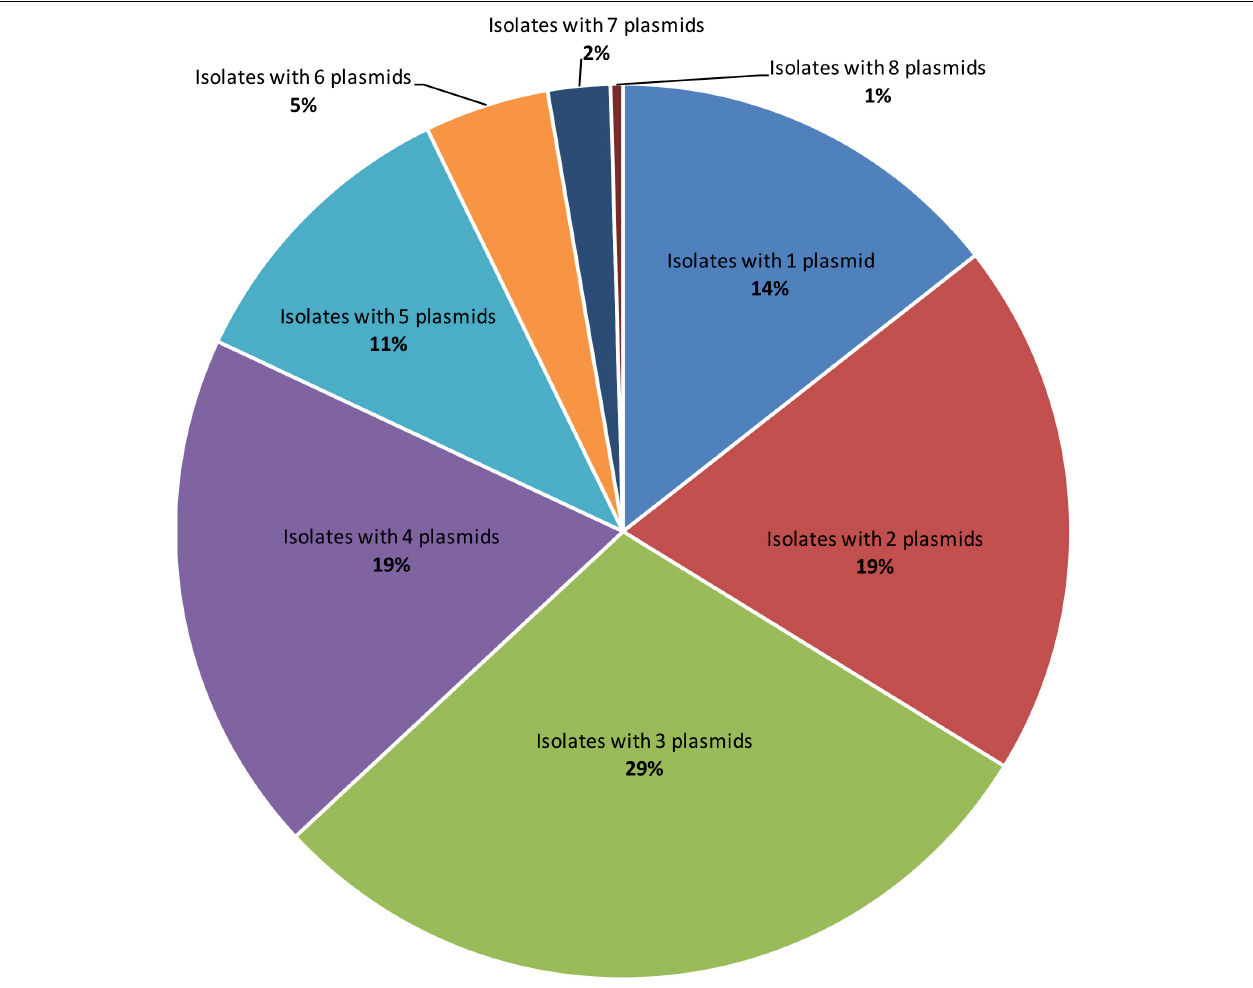
FIGURE 2 | The distribution of number of plasmids detected per a single S. aureus isolate applying TENS and PFGE methods. Each colored slice in the pie chart refers to counts of isolates with particular plasmid numbers. In case the same plasmid size were detected by both methods, only one plasmid was